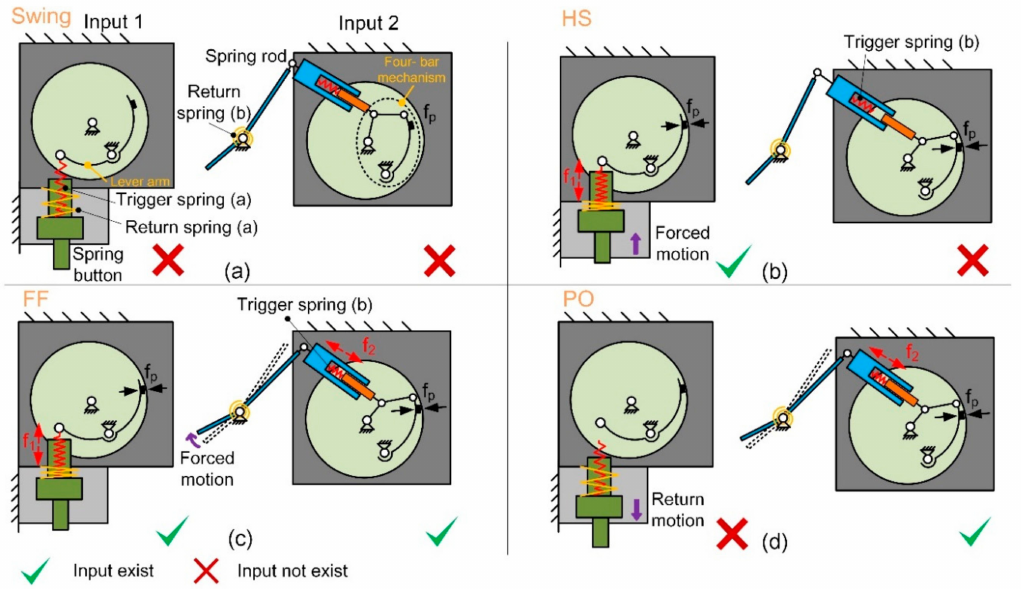
Figure 5. State of the executing part and the corresponding gait phases. ( a ) Swing: neither of trigger springs (a) and (b) is compressed; ( b ) heel strike (HS): only trigger spring (a) is compressed; ( c ) flat foot (FF): both trigger springs (a) and (b) are compressed; ( d ) push-o ff (PO): only trigger spring (b) is compressed.